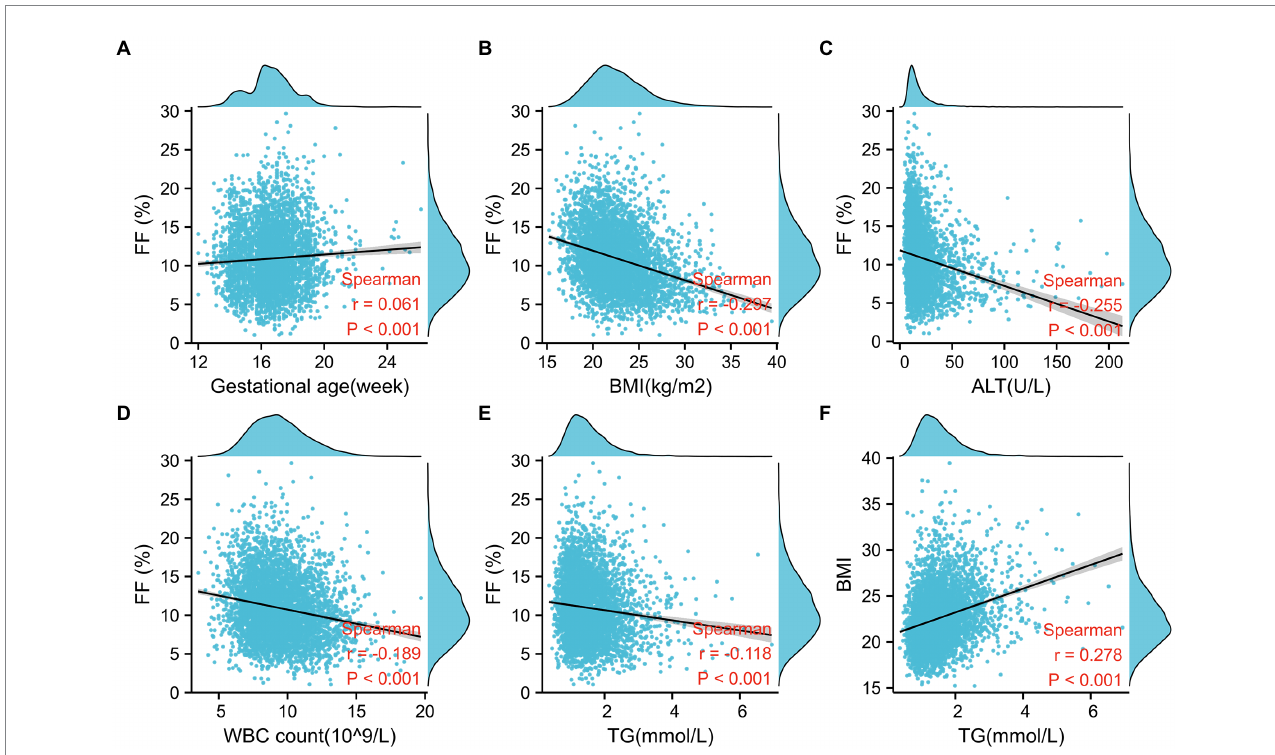
FIGURE 1 Factors associated with fetal fraction (FF) in noninvasive prenatal testing. (A) Gestational age is positively correlated with FF. (B–E) FF decreases with a higher BMI, alanine aminotransferase level (ALT), white blood cell (WBC) count, and TG level. (F) TG is positively correlated with